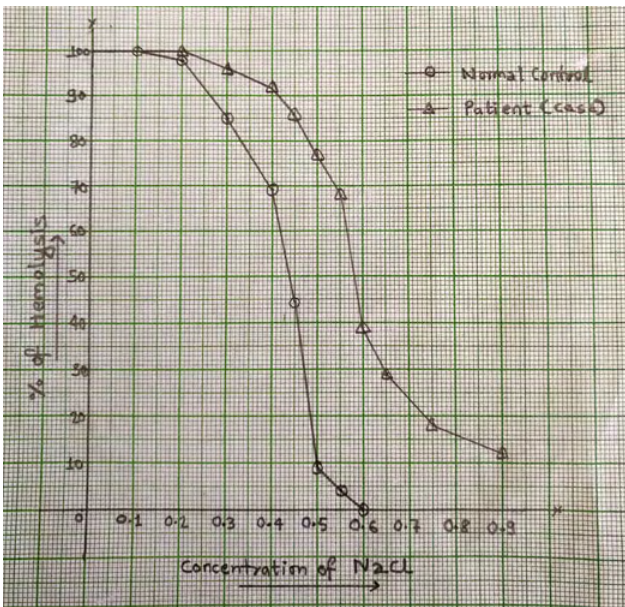
Fig 2 : Osmotic fragility in normal people and those with heriditary